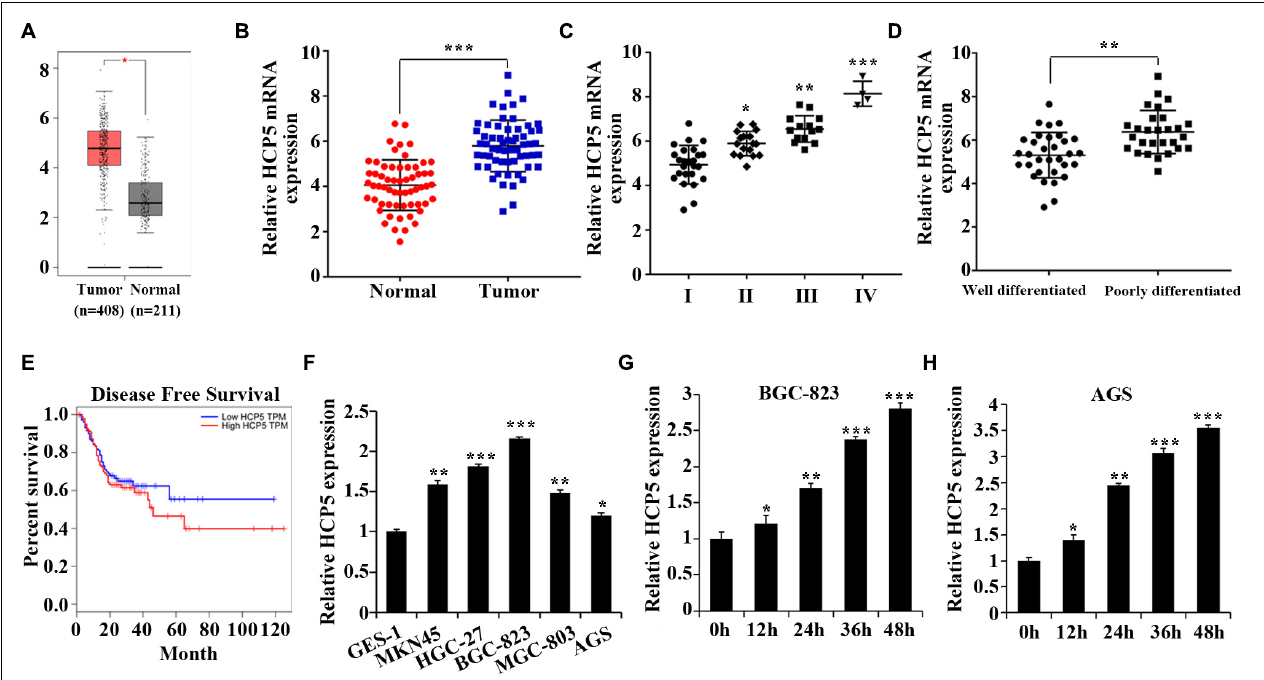
FIGURE 1 | Upregulation of HCP5 expression in gastric cancer and hypoxia-induced promotion of HCP5 expression. (A) TCGA database results of HCP5 expression in gastric cancer (GC) tissues and adjacent tissues. (B) qRT-PCR-based detection of HCP5 expression in GC tissues and adjacent tissues; *** p < 0.001 vs. normal group. (C) qRT-PCR-based detection of HCP5 expression in GC tissues in different stages; * p < 0.05, ** p < 0.01, *** p < 0.001 vs. Group I. (D) qRT-PCR-based detection of HCP5 expression in GC tissues with different degree of differentiation; ** p < 0.01 vs. well-differentiated group. (E) TCGA database results of disease-free survival of GC patients with high or low expression of HCP5. (F) qRT-PCR analysis of HCP5 expression in normal gastric epithelial cells (GES-1) and GC cells (MKN45, HGC-27, BGC-823, MGC-803, and AGS; * p < 0.05, ** p < 0.01, *** p < 0.001 vs. GES-1 cells. (G,H) qRT-PCR analysis of HCP5 expression in BGC-823 and AGS cells with induction of 1% O 2 for 0–48 h; * p < 0.05, ** p < 0.01, *** p < 0.001 vs. 0 h